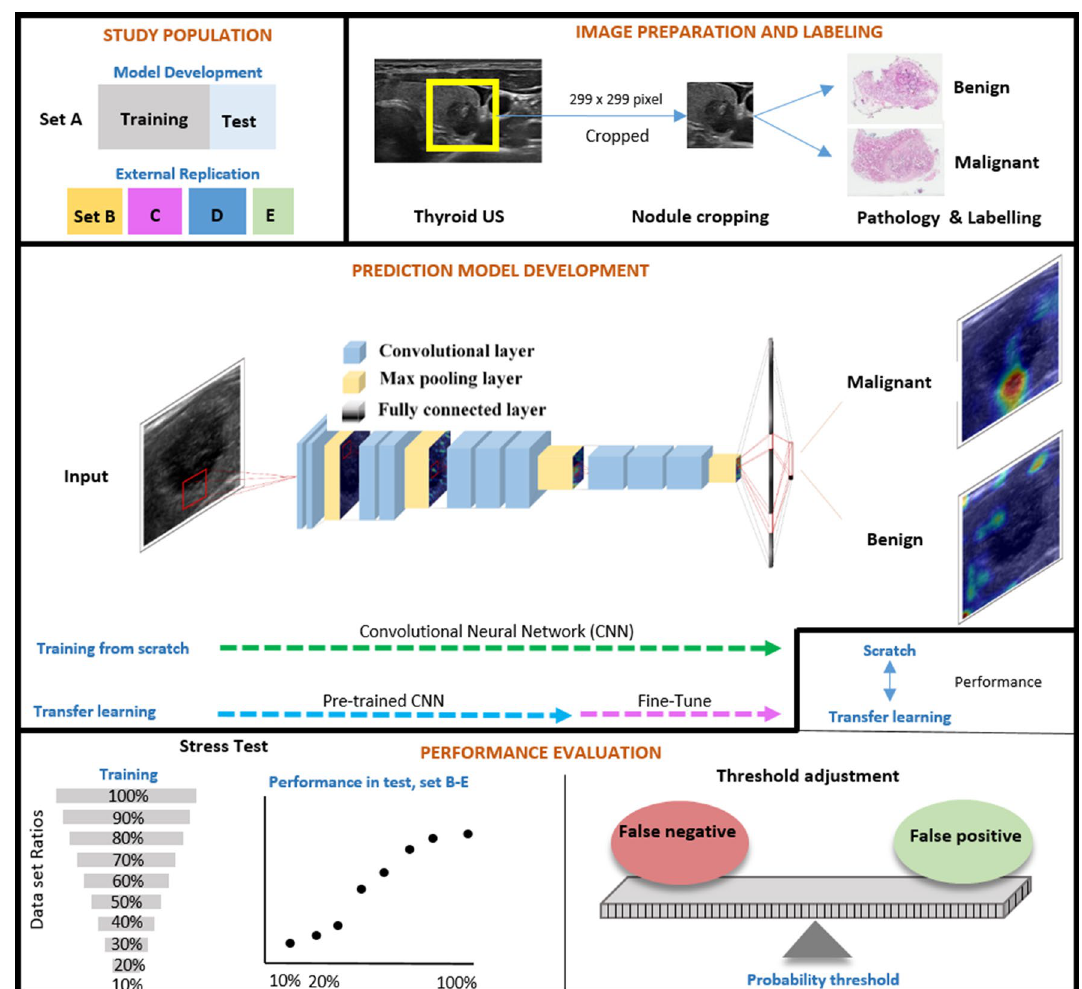
Figure 2. Overview of the study